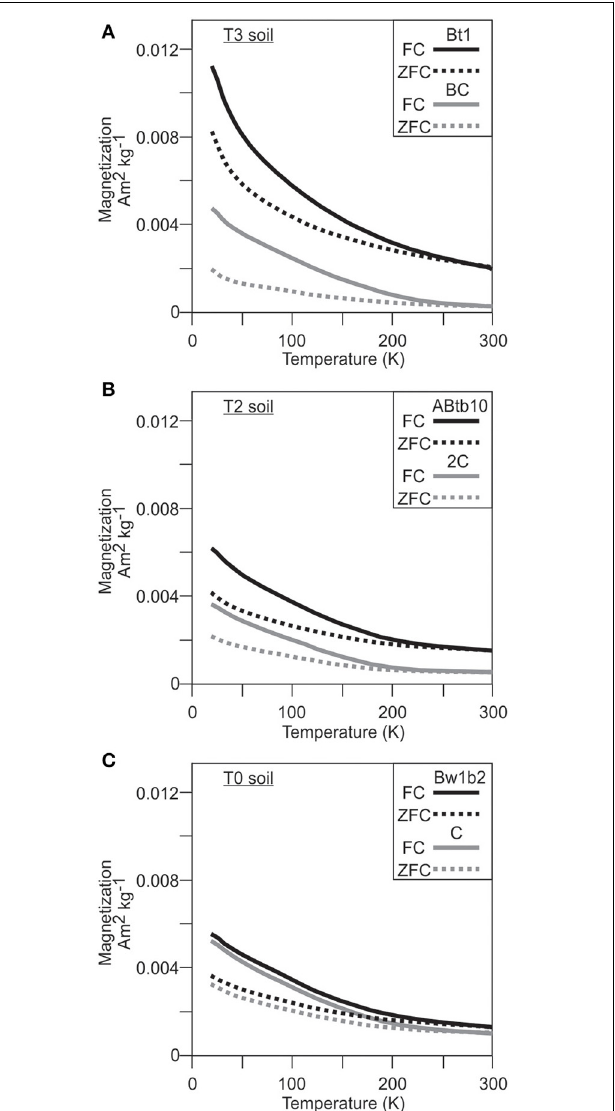
FIGURE 9 | Room temperature-SIRM (RT-SIRM) curves on cooling and warming for soils along the (A) T3, (B) T2, and (C) T0